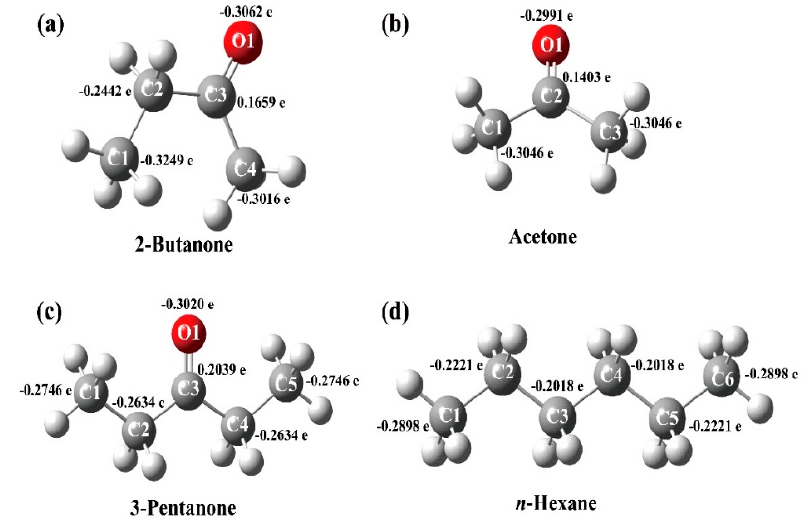
Figure 7. The 3D molecular structures and the partial charge distribution in molecules of 2-butanone ( a ), acetone ( b ), and 3-pentanone ( c ) and n -hexane ( d ).